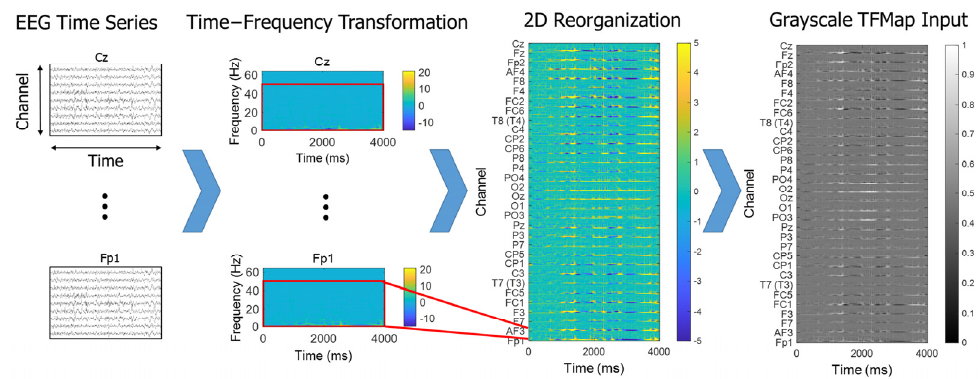
Figure 5. Process of transforming EEG time series data into a time–frequency map. The EEG time series data acquired were converted into a time–frequency map according to the power spectrum function. Then, each channel’s time–frequency map (TFMap) matrix was converted into two dimen- sions using valid frequency bands. Finally, the real-value time–frequency map matrix was converted into a grayscale image and used as an input to the